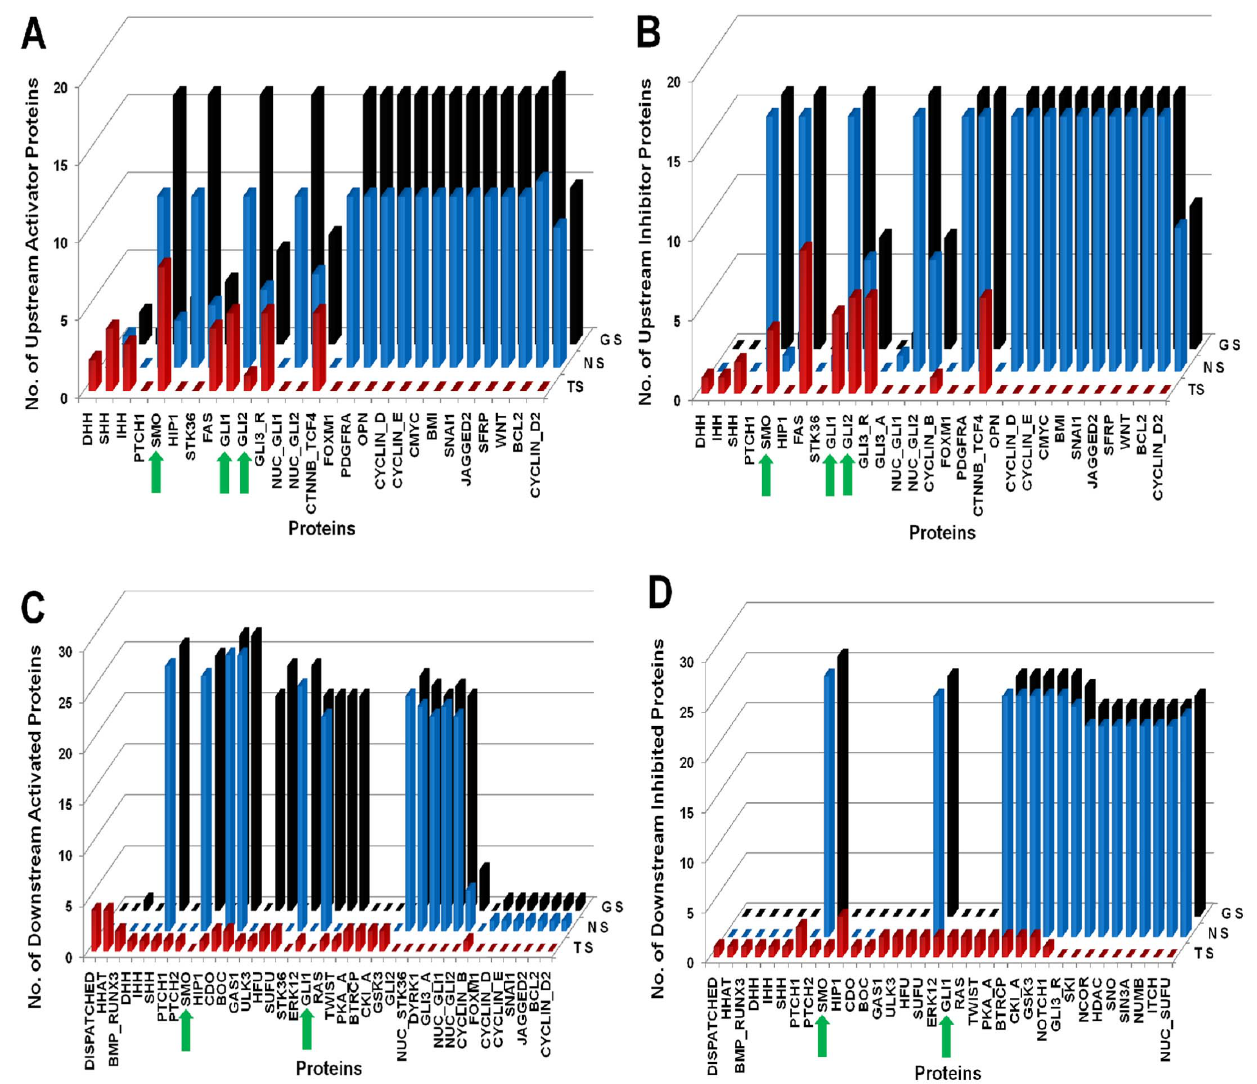
Figure 4. Comparison between Normal, Cancer and Perturbed scenarios for Glioma. TS: Treated Scenario; NS: Normal Scenario; GS: Glioma Scenario. The green arrow heads are indicating the minimal combination of proteins which was inhibited in the drug treated perturbation analysis. (A) Represents number of Upstream activator proteins (Y-axis) activating the proteins (X-axis) representing significant variations. Compared to the normal scenario, proteins, SHH, SMO, GLI1, GLI2, and output proteins BMI, SNAI1, BCL2 and Cyclins, are activated by maximum number of upstream activator proteins. On drug treated perturbation of SMO, GLI1 and GLI2, the number of activators of the output proteins become zero. (B) Represents number of Upstream inhibitory proteins (Y-axis) inhibiting the proteins (X-axis) representing significant variations. The numbers of upstream inhibitor proteins in normal versus Glioma scenario remain same. Similar perturbation results are observed as in (A). (C) Represents number of Downstream proteins (Y-axis) activated by the proteins (X-axis) representing significant variations. The number of downstream proteins activated in normal versus Glioma remains same. On perturbation of SMO, GLI1 and GLI2, the number of downstream proteins activated by these proteins is reduced to zero. (D) Represents number of Downstream proteins (Y-axis) inhibited by the proteins (X-axis) representing significant variations. The number of downstream proteins inhibited in normal versus Glioma remains the same.